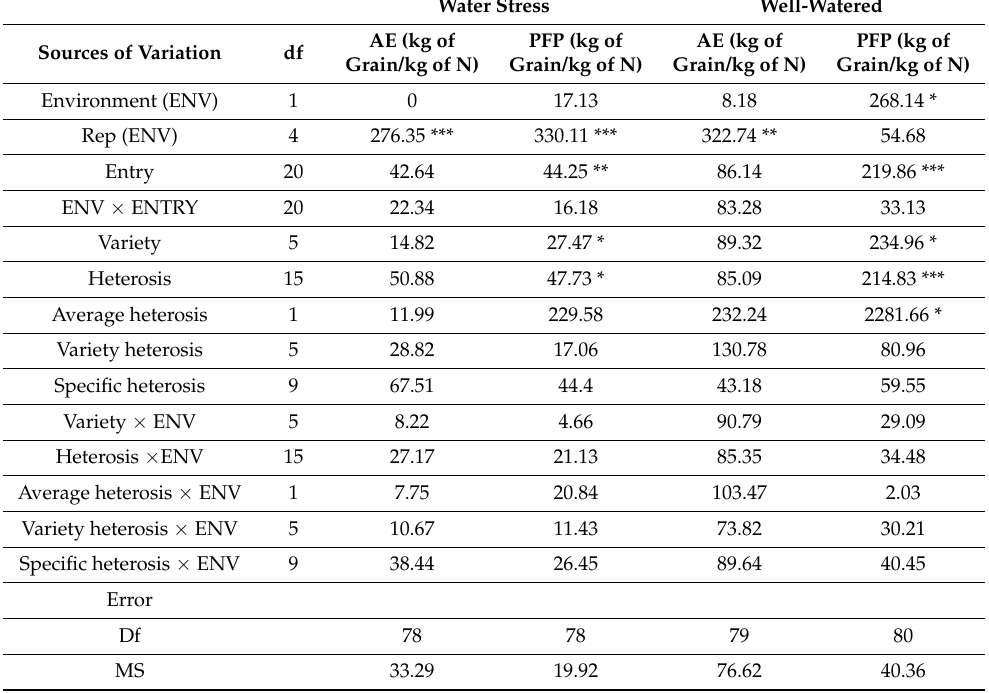
Table 8. Mean squares for agronomic efficiency (AE) and partial factor productivity (PFP) from analysis II of Gardner and Eberhart [77] of the diallel made with six Algerian maize populations evaluated along with four checks in two years in Algiers under drought and nitrogen